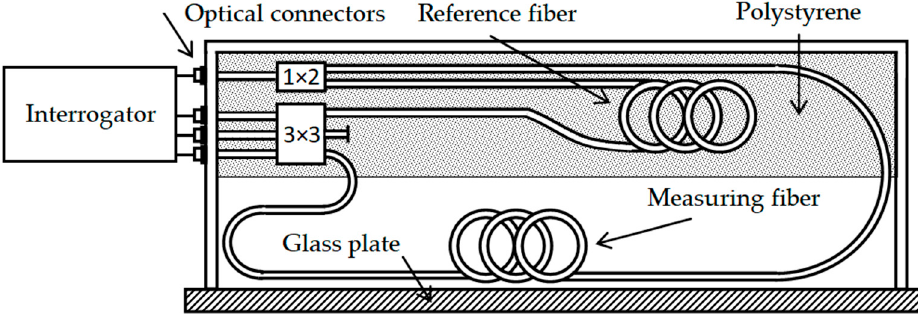
Figure 3. Connection of the interrogator unit with the fiber-optic interferometric sensor.